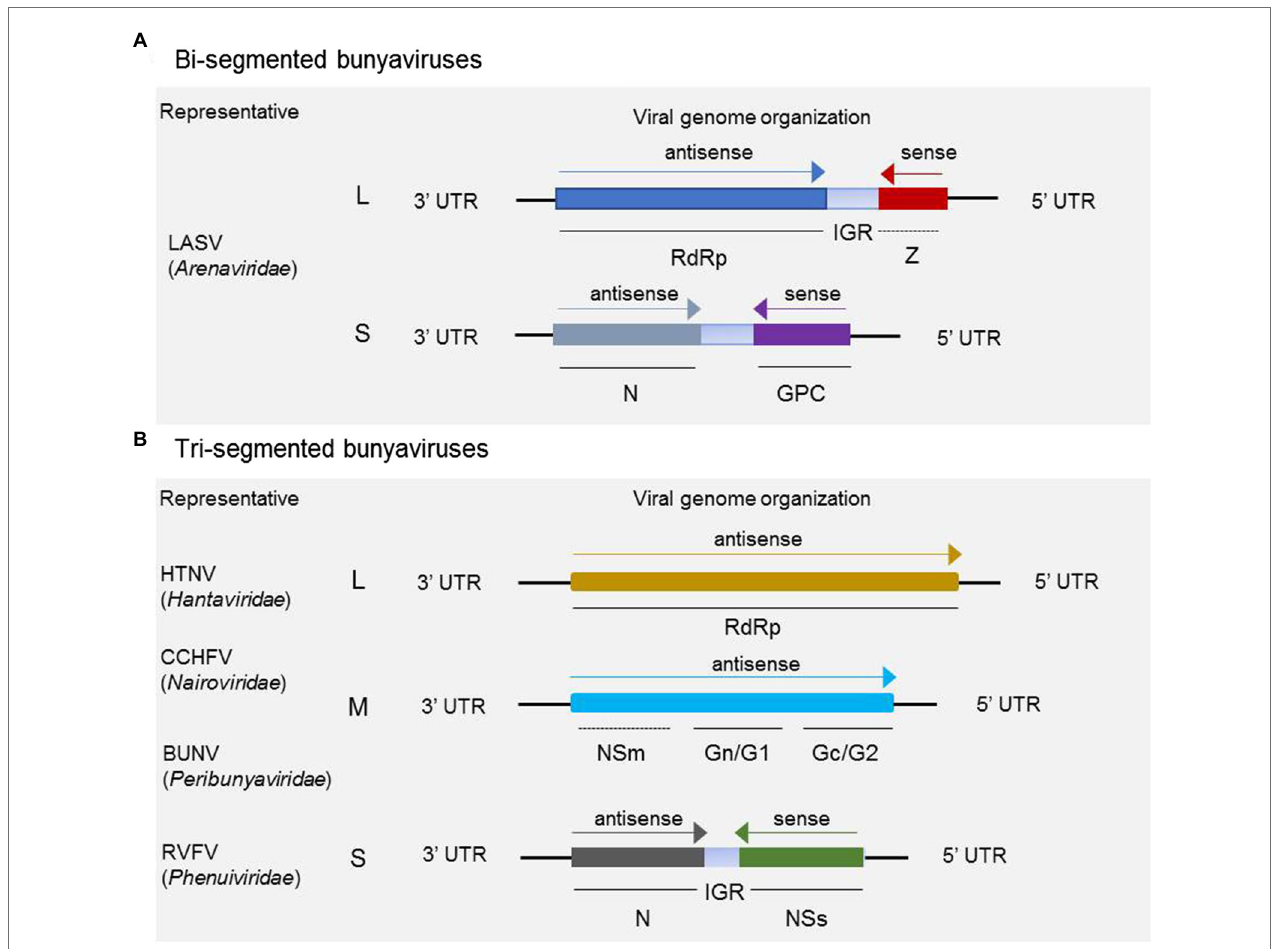
FIGURE 1 | Schematic of genome organization and coding strategies of bisegmented and trisegmented bunyaviruses. For bisegmented bunyaviruses, in Lassa arenavirus (LASV), for example, the L and S are generally ambisense segments, of which the L codes for RdRp and a zinc-binding protein (Z), and S codes for glycoprotein precursor (GP) and nucleoprotein (N). The Z protein is only encoded by some members in Mammarenavirus and Reptarenavirus (A) ; (B) for trisegmented bunyaviruses, such as Hantaan virus (HTNV), Crimean-Congo hemorrhagic fever virus (CCHFV), Bunyamwera virus (BUNV), and Rift Valley fever virus (RVFV), the viral genome consists of L, M, and S, of which the L codes for RdRp and M mainly codes for glycoprotein Gn (or G1) and Gc (or G2). For CCHFV, BUNV, RVFV, and several other members not shown here, the M segment also encodes NSm besides the glycoproteins. It should be noted that the NSm encoding gene of CCHFV and BUNV is both located between the encoding genes of Gn and Gc, which is different from the schematic shown for RVFV. The S segment adopts an ambisense coding strategy to encode nonstructural protein NSs and nucleoprotein